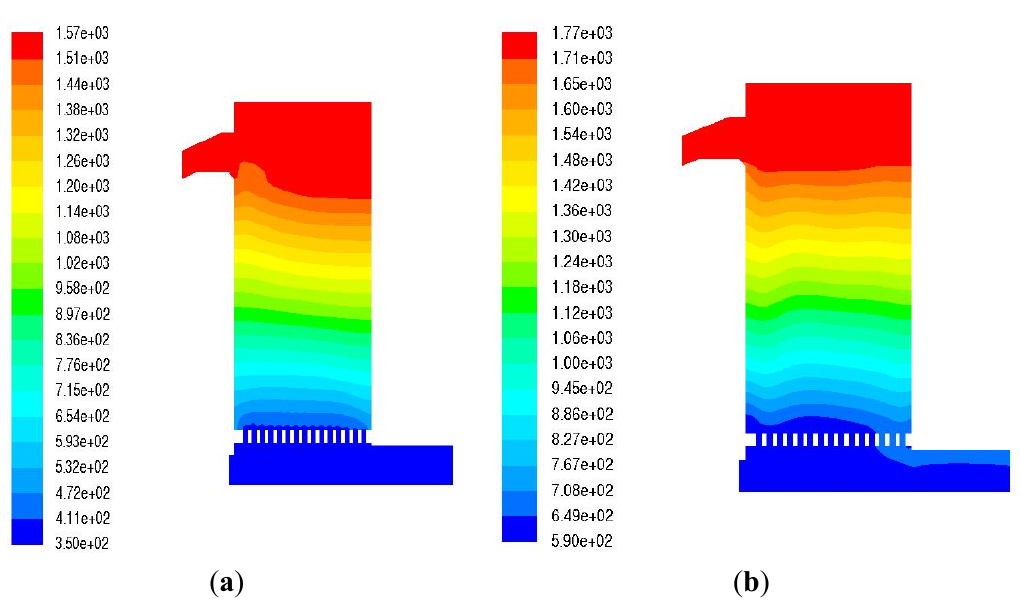
Figure 9. Temperature [K] distribution during air flow ( a ) and exhaust gases flow ( b